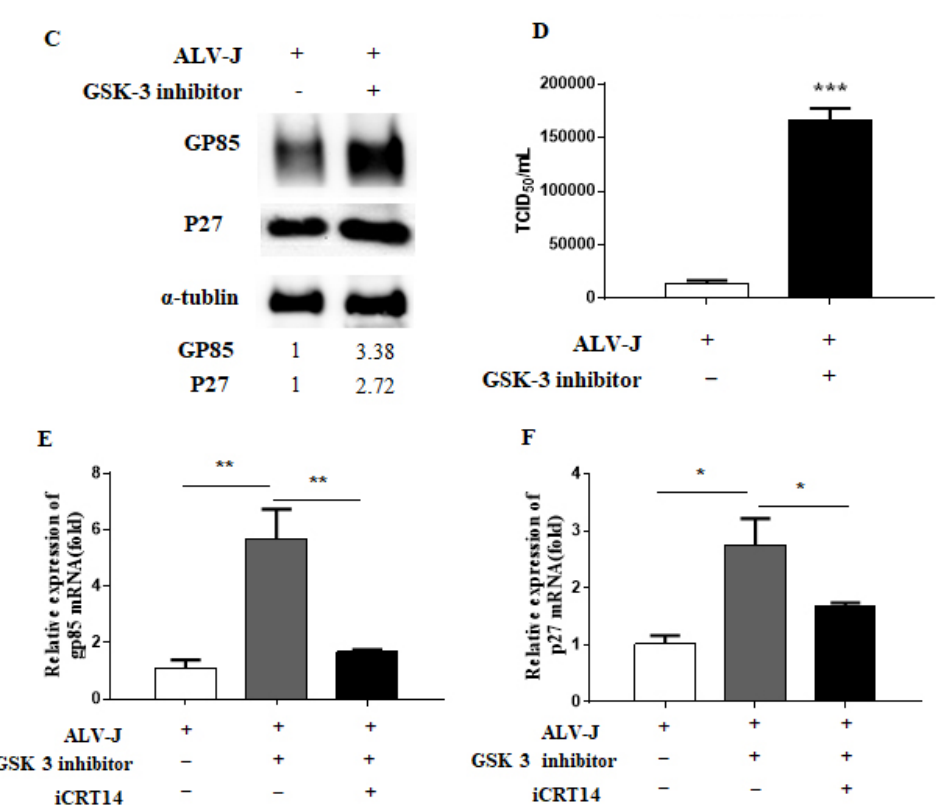
Figure 2. GSK-3 inhibitor induced ALV-J replication via the Wnt/ β -catenin signaling pathway. Effects of GSK-3 inhibitor on the expression levels of the gp85 ( A ) and p27 ( B ) genes were quantified by real-time RT-PCR. ( C ) The viral gp85 and p27 protein levels were measured by immunoblotting at 72 h postinfection. The control α -tubulin levels indicate that similar levels of protein were loaded into each lane, and the grayscale value of the bands in Western blot were analyzed with Image J software. ( D ) Virus production was analyzed by virus titration assay in CEF cells treated with 5 μM GSK-3 inhibitor and DMSO control. The gene expression levels of gp85 ( E ) and p27 ( F ) induced by GSK-3 inhibitor were restored by iCRT14. Data were expressed as mean ±SD from three independent experiments and analyzed by Student’s t -tests (* p < 0.05, ** p < 0.01, *** p < 0.001). These experiments were performed independently at least three times with similar results.